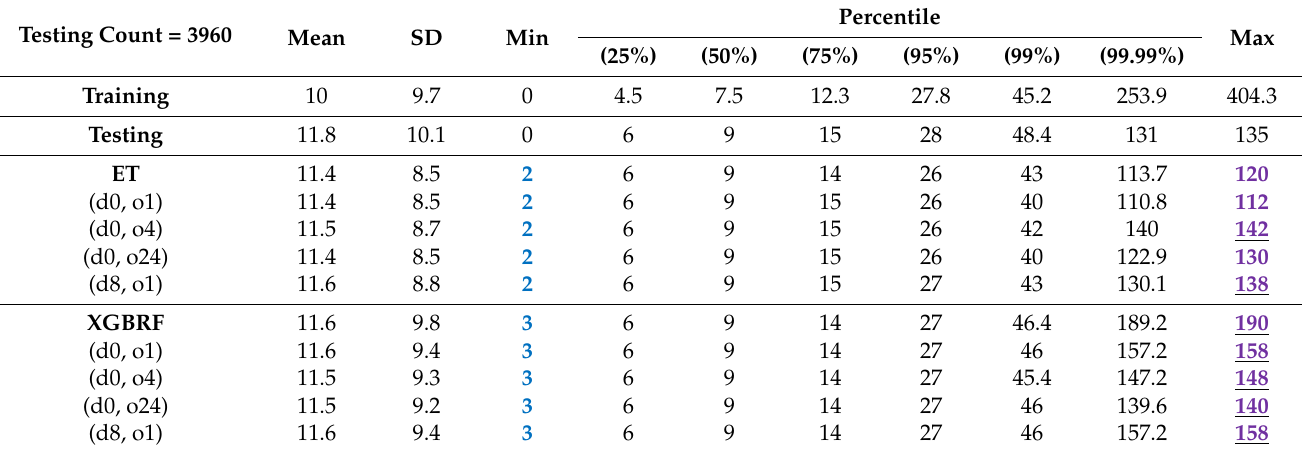
Table 11. Output statistics of Extra Trees and XGBRF along with NARX vs. the training and testing output for the seventh iteration for the Manchester